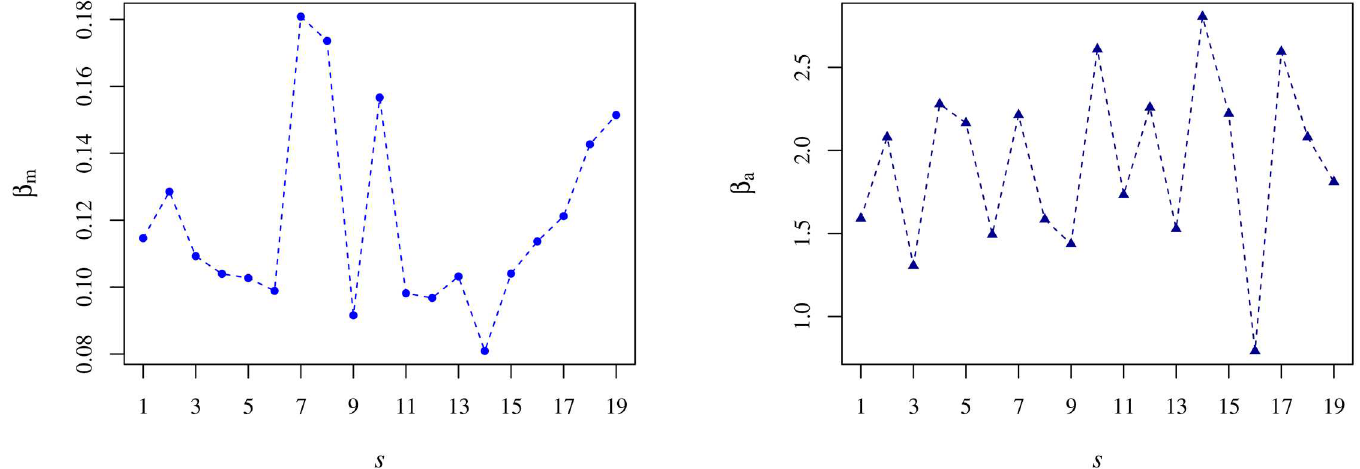
Fig 11. Relaxation exponents of the kurtosis in Eq (18) as a function of the semester. The left panel depicts the evolutionof the morning exponent, β m , and the right panel the same but for the afternoon exponent, β a . Both exponentsdiffer from each other by a factor